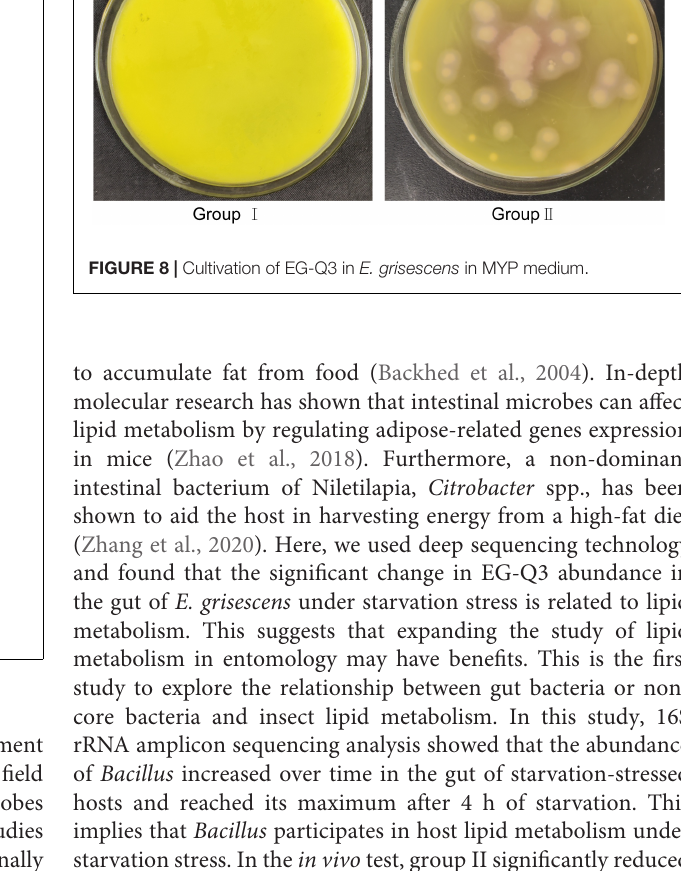
Frontiers in Microbiology |